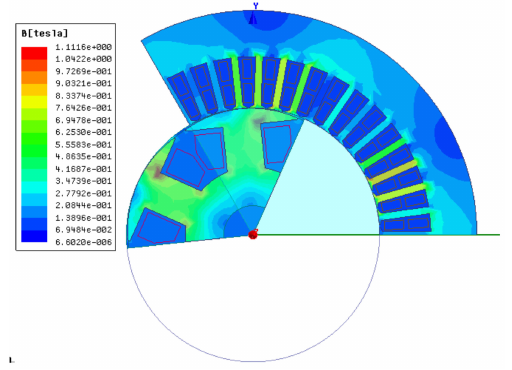
Figure 8. Electrical parameter variation curve of the generator is rated: ( a ) Stator current; ( b ) Electromagnetic torque.